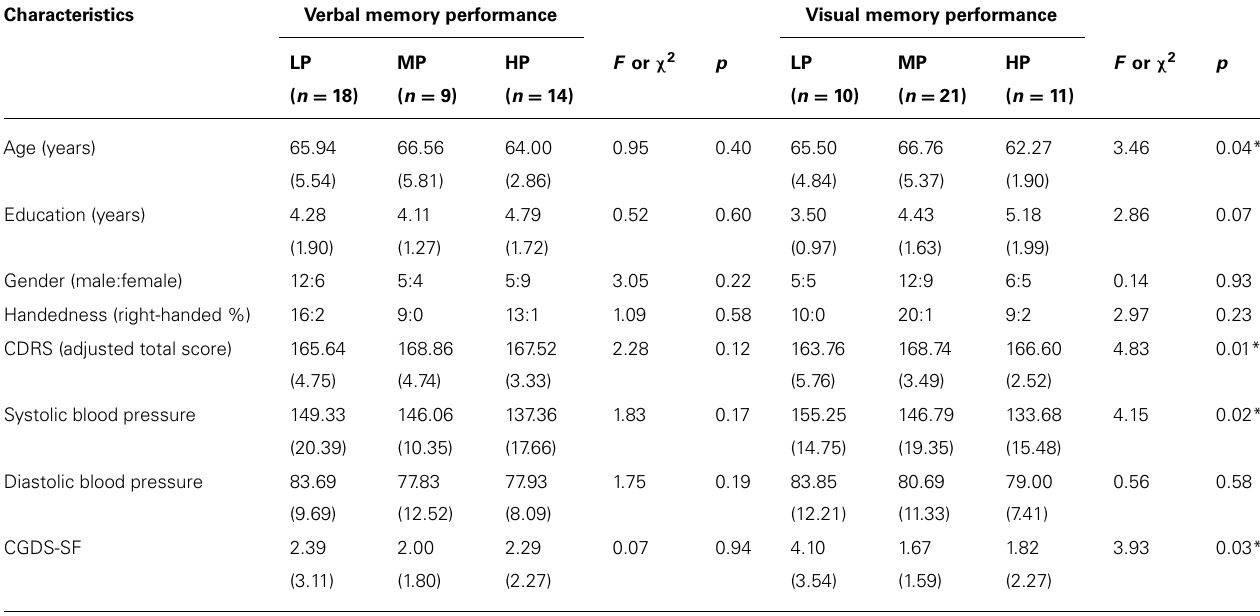
Table 1 | Demographic characteristics of participants.